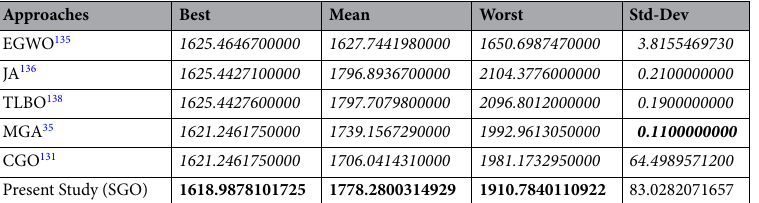
Table 13. Statistical results of different approaches for the hydro-static thrust bearing design problem. Significant values are in bold and italics.